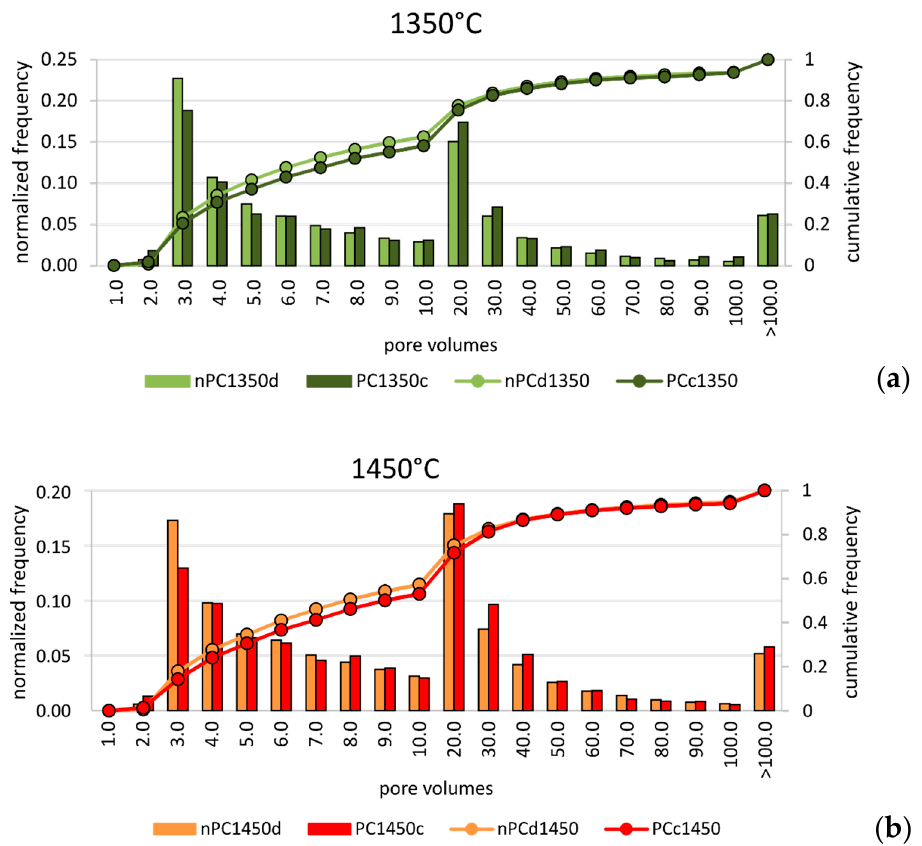
Figure 9. Pore size distribution of volumes for ( a ) nPC1350d - PC1350c and ( b ) nPC1450d - PC1450c. Both normalized frequencies (bars) and cumulative frequencies (lines) are given. The observations were grouped in 20 classes, as shown in the abscissa. Units are 10 − 6 mm 3 .